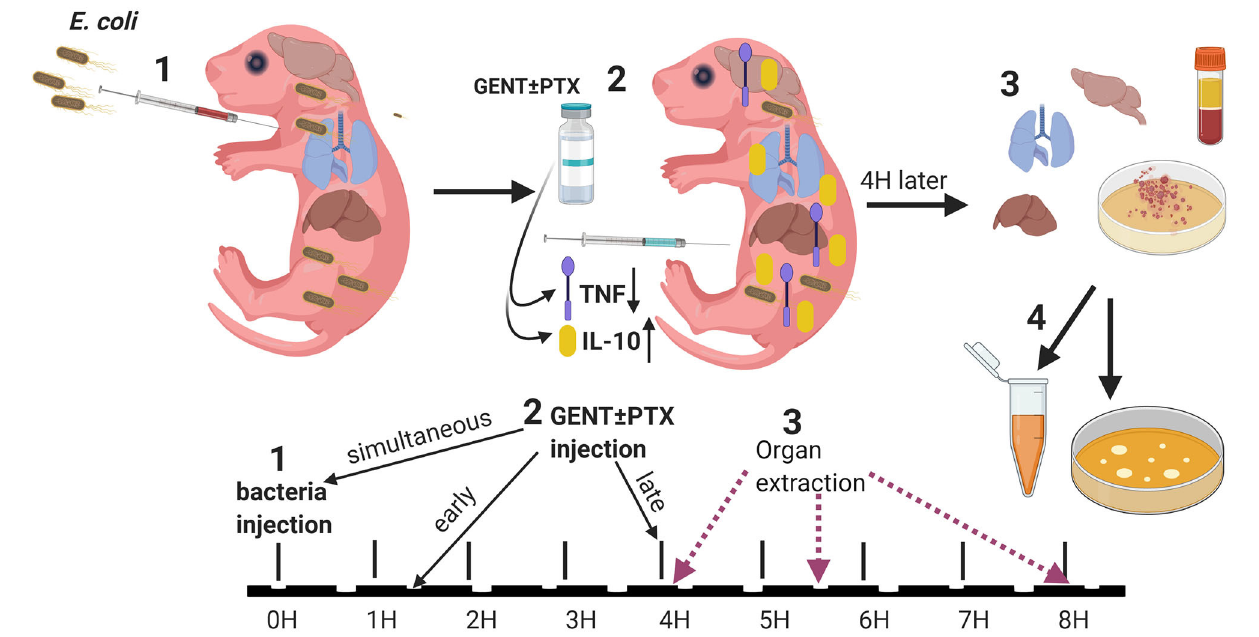
FIGURE 1 | Experimental design. (1) Neonatal mice ( < 24h old) were injected with E. coli via the right intra-jugular route at the start of the experiment (0H time point). (2) Subsequently, pups were injected intraperitoneally with GENT, PTX, (GENT + PTX), or saline control immediately following bacteria injection (simultaneously, at the